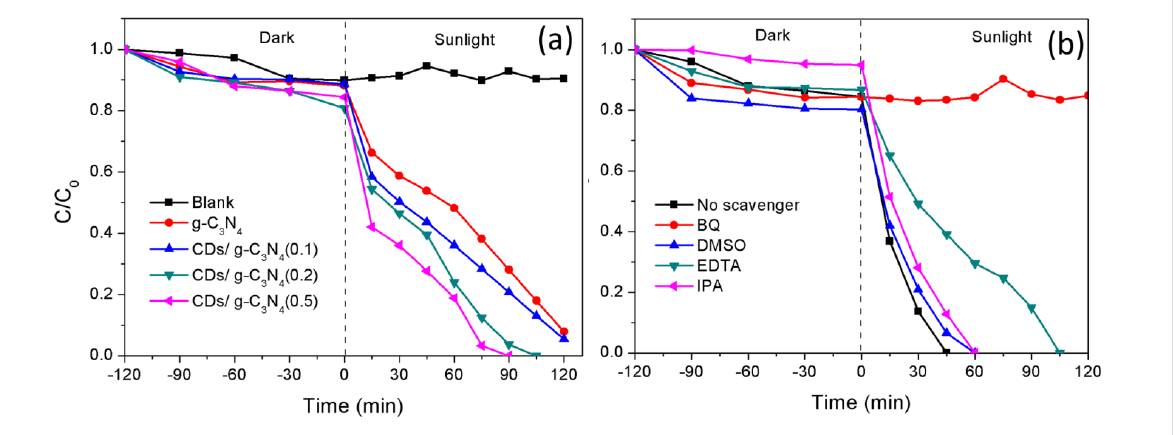
Figure 5: (a) Photocatalytic degradation of bisphenol A (BPA) as a function time under irradiation of natural sunlight, and (b) the effect of different scavengers for CD/g-C 3 N 4 (0.5) on BPA removal.